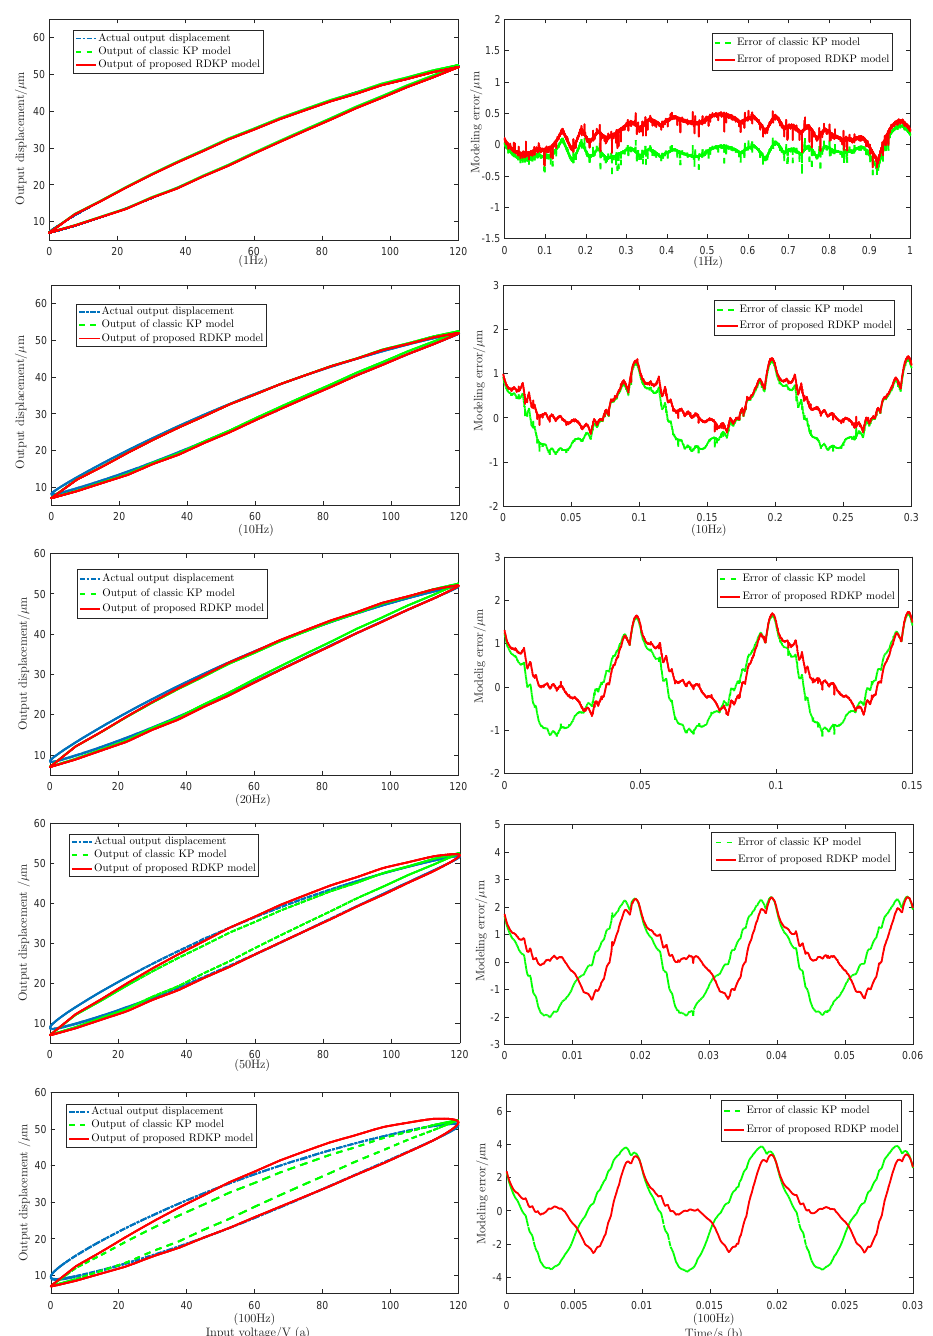
Figure 11b, it can be calculated that the RMSE and RE of the classic KP model are 1.0076 µ m and 5.57%, respectively. Additionally, the RMSE and the RE of the proposed RDKP model are 0.7065 µ m and 3.83%, respectively. The experimental results proved that the proposed RDKP model can effectively describe the rate-dependent hysteresis behavior of the piezoceramic actuated stages when the input voltage signals are sinusoidal signal and decreasing amplitude signal.